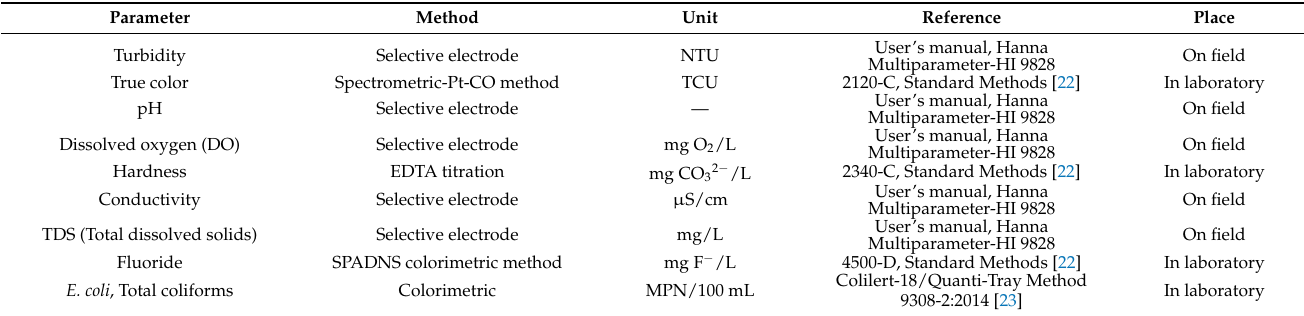
Table 3. Analysis methods for water quality parameters.